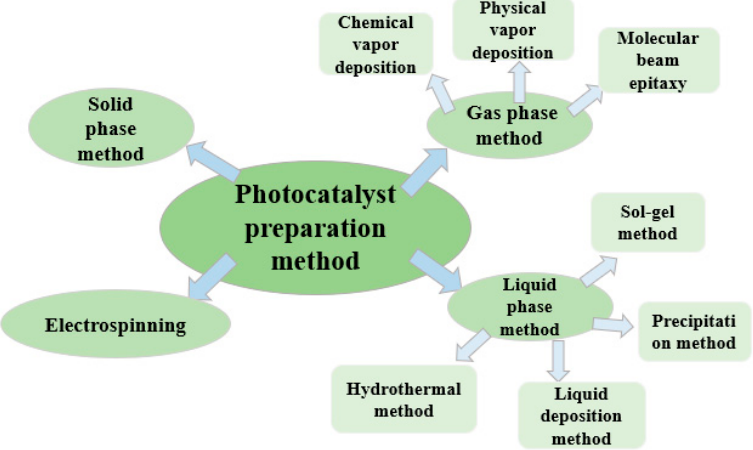
Figure 3. Photocatalyst preparation method.